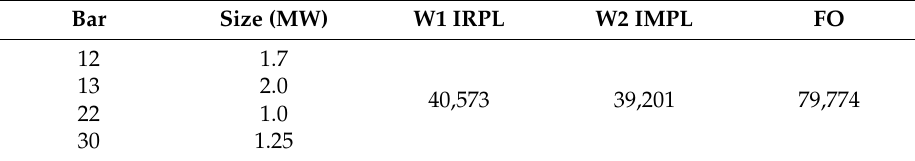
Table 7. Best result using Hybrid Genetic Algorithm (HGA).